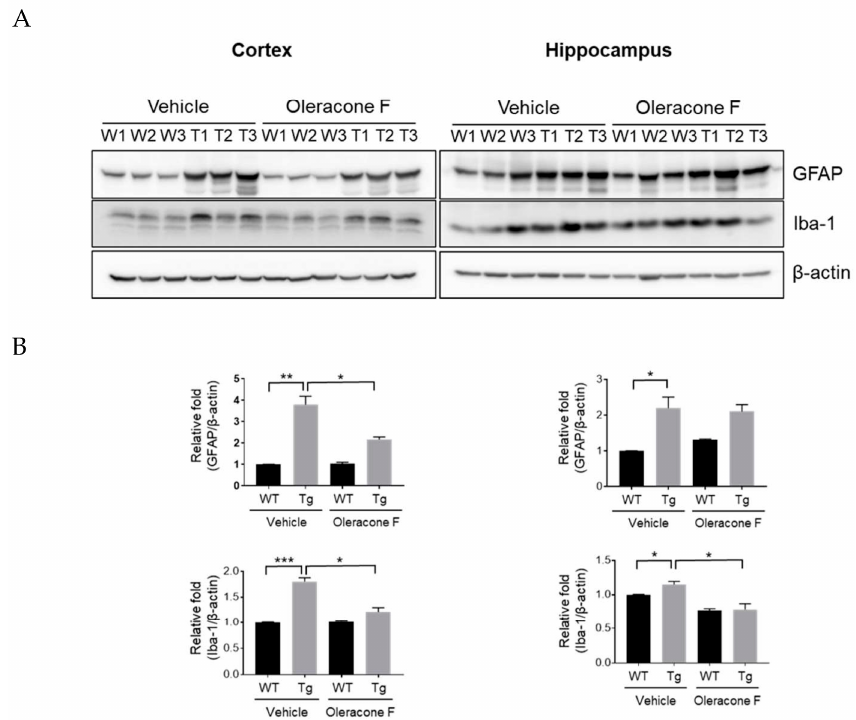
Figure 6. ( A ) The treatment of AD transgenic mice with oleracone F reduced brain inflammation. WT and Tg mice were injected with saline or oleracone F (5 μ g/kg, i.p) for 4 weeks. The GFAP and Iba-1 protein levels were determined by Western blot analysis using 30 μ g of protein extracts obtained from the mouse cortex and hippocampus. ( B ) Quantifications of the bands were performed using densitometry (ImageJ software, 1.49 v). Results were normalized to β -actin. Data represented are ± SEM (n = 3). Statistical significance are denoted ad * p < 0.05, ** p < 0.01, and *** p < 0.001.